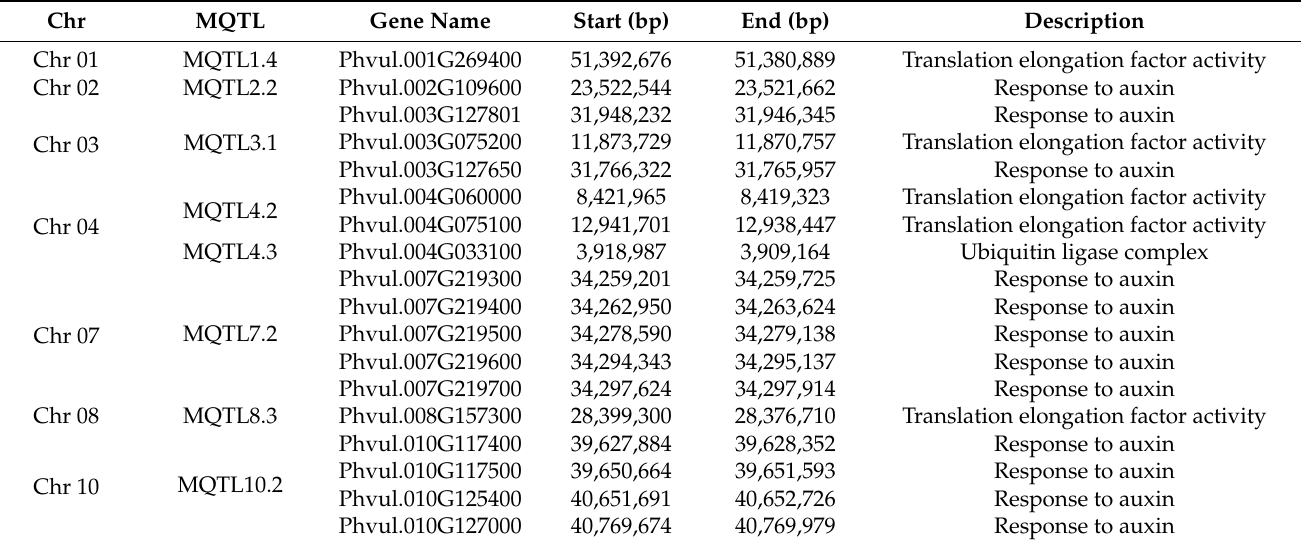
Table 4. List of candidate genes identified and associated with grain yield within the physical intervals of